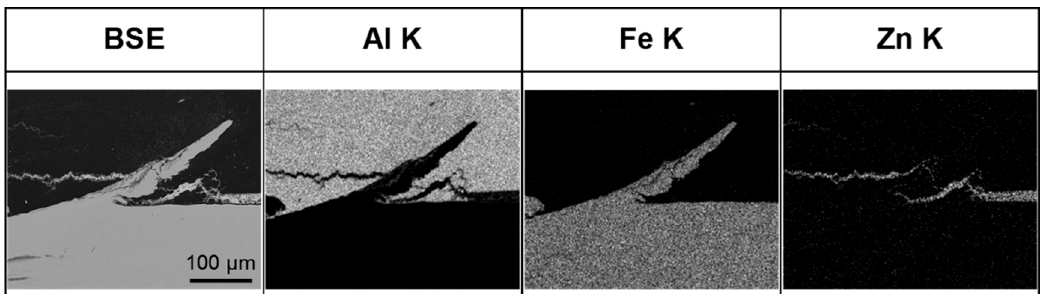
Figure 9. EDS element mapping of the center interface of sample A.